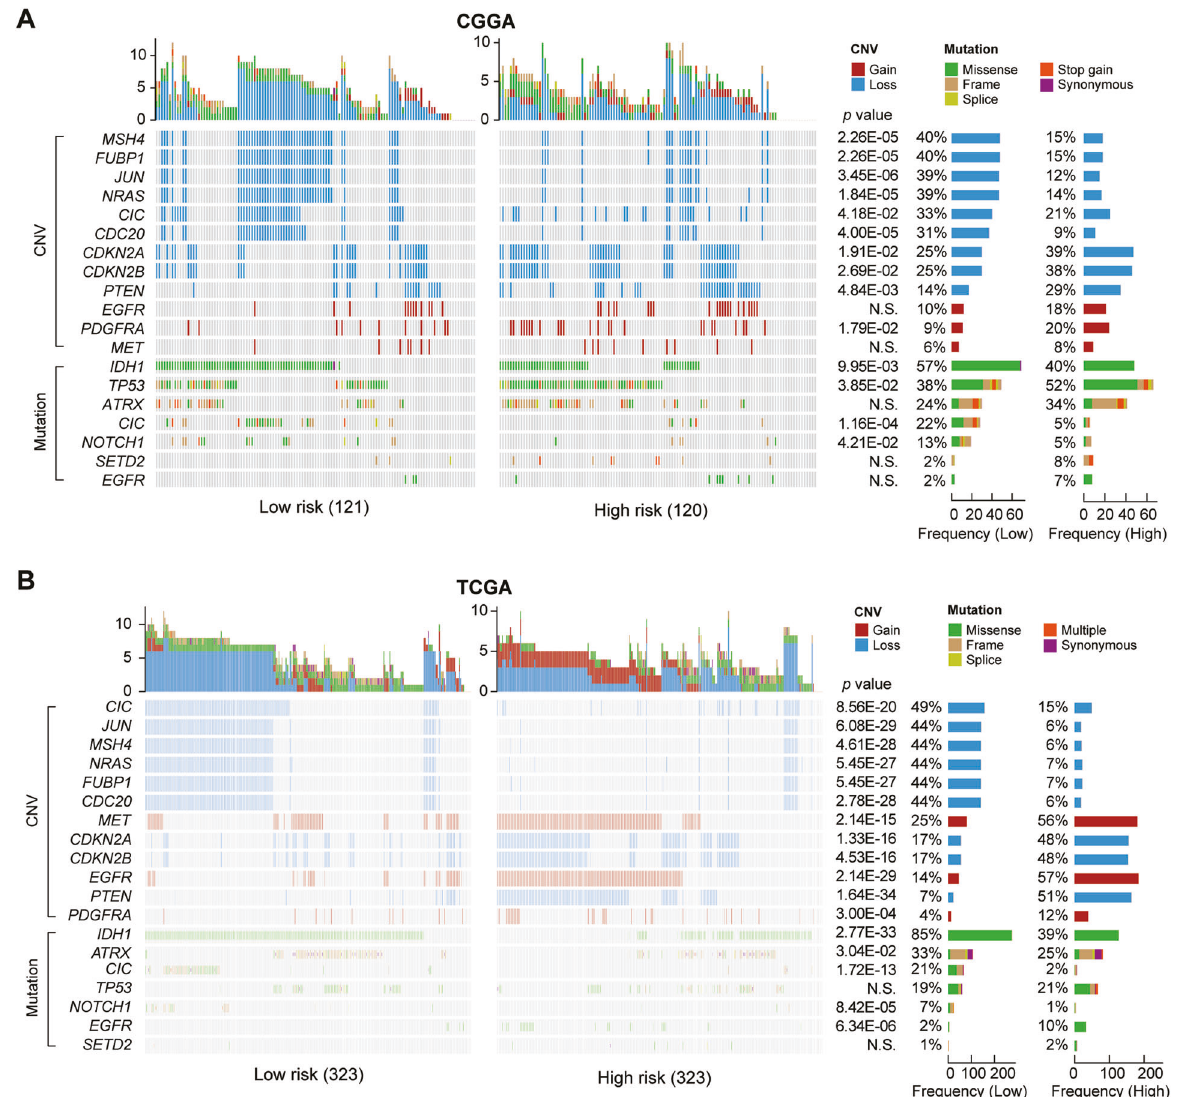
Fig. 3 Comparison of genomic alterations between the high-risk and low-risk group in the CGGA and TCGA datasets. Differential somatic mutations and copy number variations analyses within two risk groups (Fisher test) in CGGA ( A ) and TCGA ( B ) datasets. CNV copy number variations; N.S., no signi fi